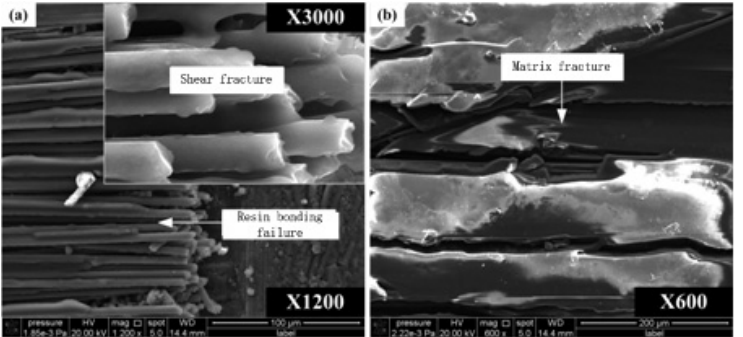
Figure 12. Fracture topography SEM photos of carbon fiber with 90° orientation angle. ( a ) 90° orientation angle with 1200X magnification; ( b ) 90° orientation angle with 600X magnification.